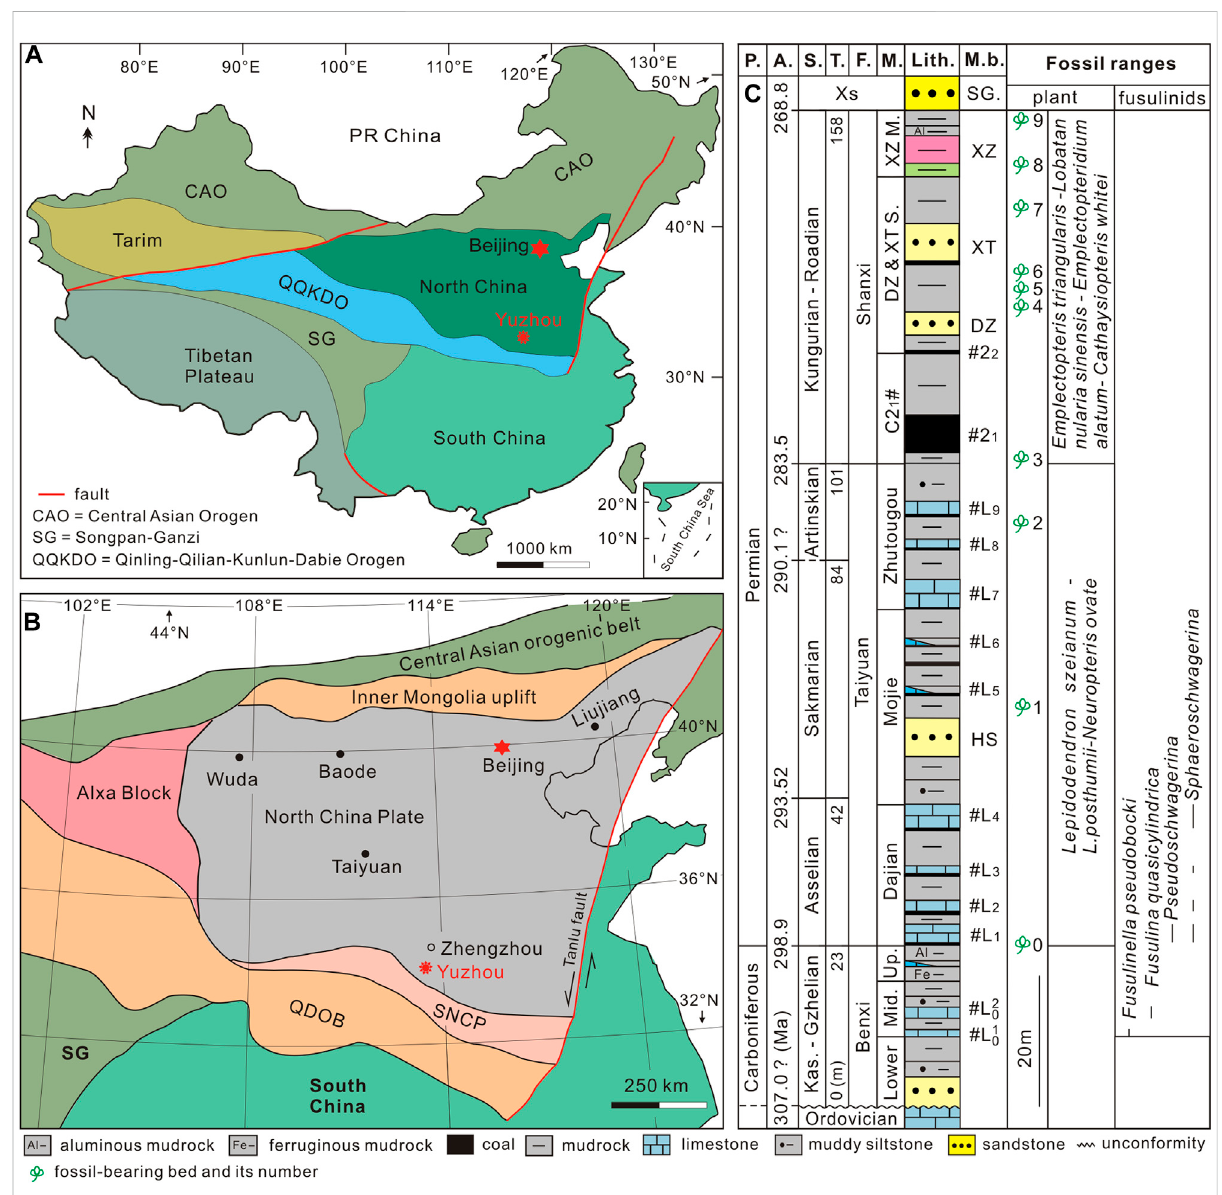
FIGURE 1 Locationandgeologicalcontextforthestudyarea. (A) Generalizedtectonicmapofpresent-dayChinashowingthelocationoftheNorthChina Plate(NCP)andthestudyarea(modi fi edfrom(Luetal.,2020)) (B) ,Simpli fi edtectonicmapofthepresent-dayNCPshowingthelocationofthestudy area (modi fi ed from (Lu et al., 2021c)). (C) Stratigraphic framework and fossil distributions for the studied Carboniferous-Permian strata of the Benxi, Taiyuan,Shanxi,andXiashihezi(Xs)formationsfromHenanProvinceinthesouthernNCP.Lithologycolumnderivedfrom(Pei,2004)and(Yang, 2006) with colors representing those of the strata in the fi eld (Section 2). L 0 1 to L 9 represent the position of individual limestone marker beds. Fossil plant assemblages (0 – 9) from (Yang, 2006) and (Yang and Wang, 2012). Fusulinid stratigraphic ranges and biozones from (Pei, 2004, 2009). Abbreviations:SG=Songpan-GanziTerrane;QDOB=Qingling-Dabieorogenicbelt;SNCP=southNorthChinaPlate;P.=period;S.=stages;Kas.= Kasimovian; T. = cumulative thickness; F. = formation; M. = member; C2 1 # = Coal 2 1 seam member; DZ & XT S. = Dazhan and Xiangtan Sandstone Member; XZ M. = Xiaozi Mudrock Member; Mid. = middle; Up. = upper; Lith. = Lithology; M.b. = marker bed; HS= Hushi sandstone; 2 1 # = Coal 2